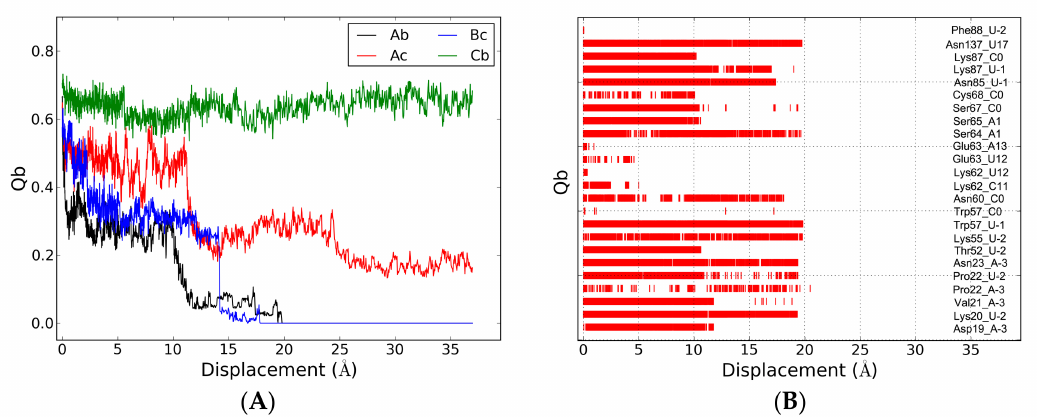
Figure 8. ( A ) Binding contact (Qb) between ToxN and ToxI as a function of displacements. The uppercase and lowercase letters are for ToxN and ToxI, respectively. ( B ) The Qb of residue-nucleotide pair between ToxN(A) and ToxI(b) along the SMD1